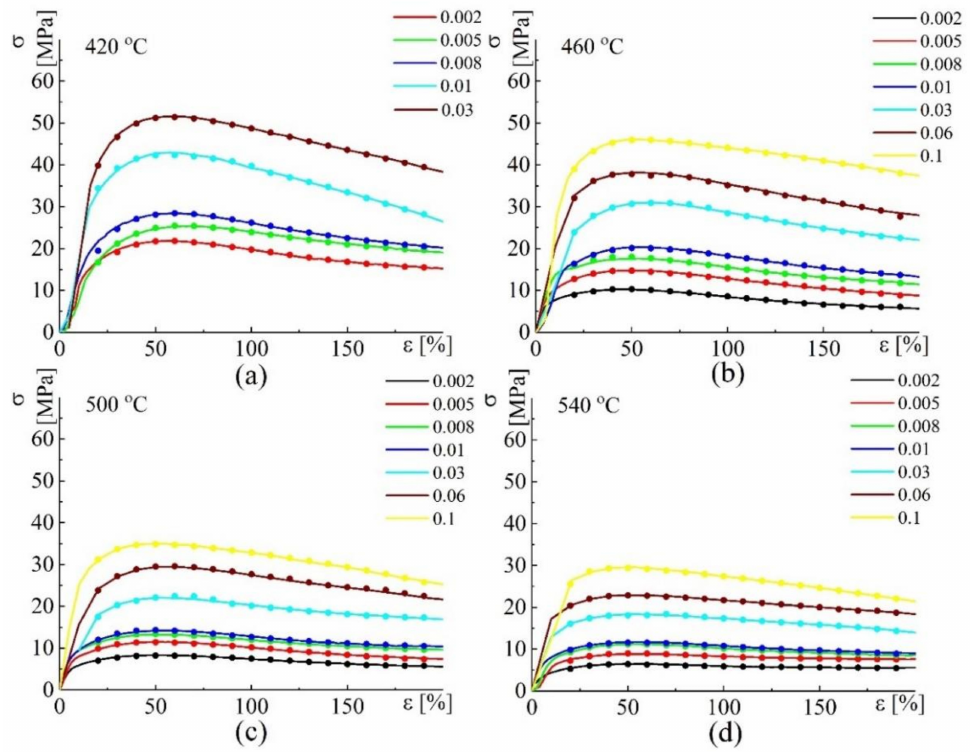
Figure 10. Experimental and predicted stress vs. strain via the ANN model at different strain rates and temperatures of ( a ) 420 ◦ C, ( b ) 460 ◦ C, ( c ) 500 ◦ C, and ( d ) 540 ◦